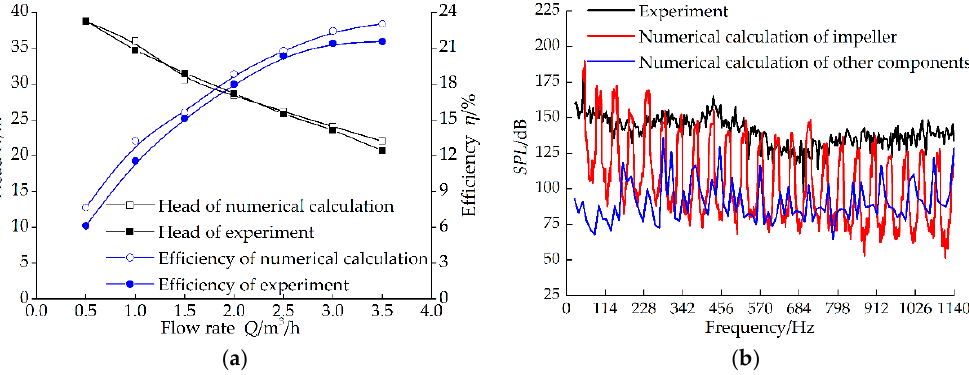
Figure 9. Comparison of performances between experiment and numerical calculation. ( a ) Comparison of hydraulic performance; ( b ) Comparison of frequency response curves of sound pressure level.